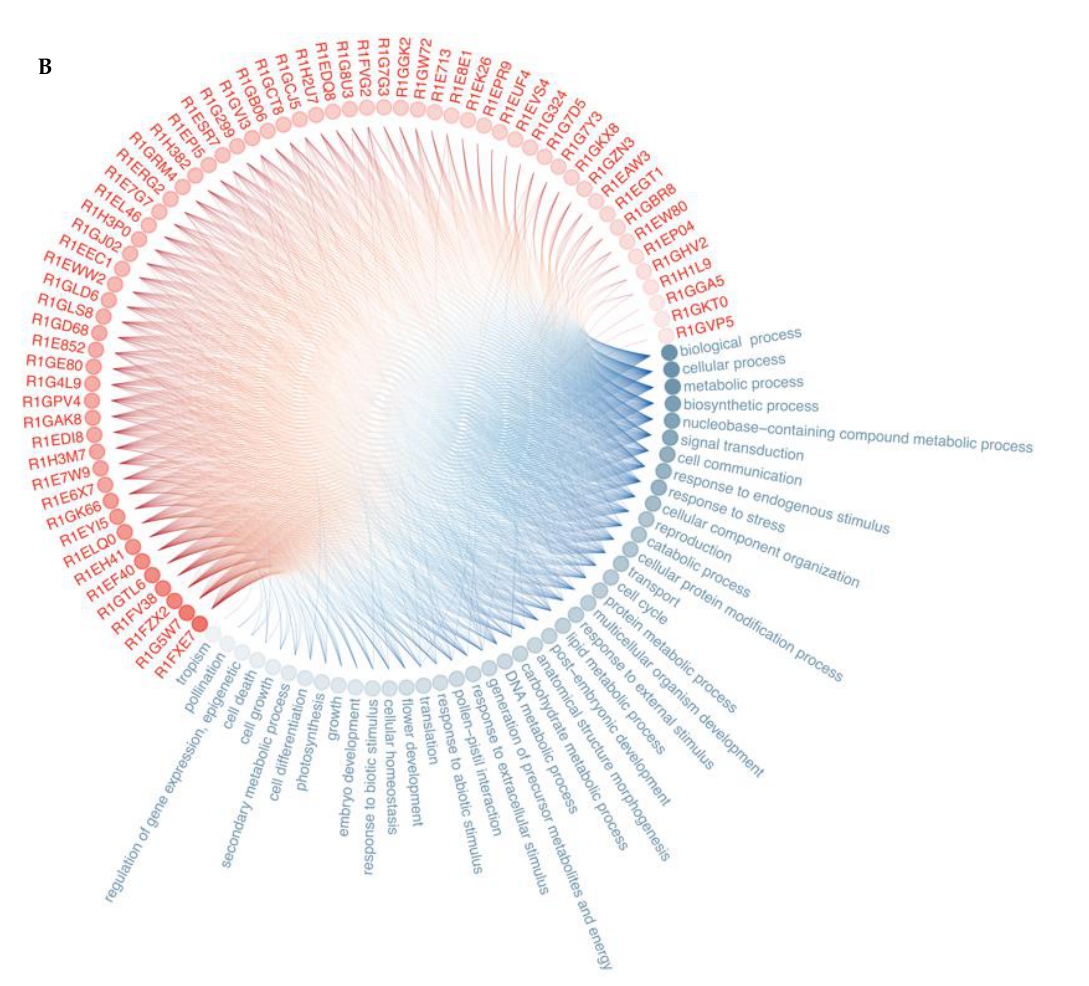
Figure 2. PPIs network prediction between secreted proteins from N. parvum (red) and the reference proteome of Eucalyptus globulus (blue). ( A )—PPI interactions, the figure produced using Cytoscape v3.7.2. ( B )—Visualization of the interactions between N. parvum proteins and the Biological Processes of the Eucalyptus -interacting proteins. The opacity of dots for each protein/protein category reflects the observed number of interactions. Table 3. Summary of the proteins with the highest number of PPI between proteins differentially secreted by Neofusicoccum parvum (CAA704) and Eucalyptus grandis proteins. The “Degree” stands for the number of interactions.